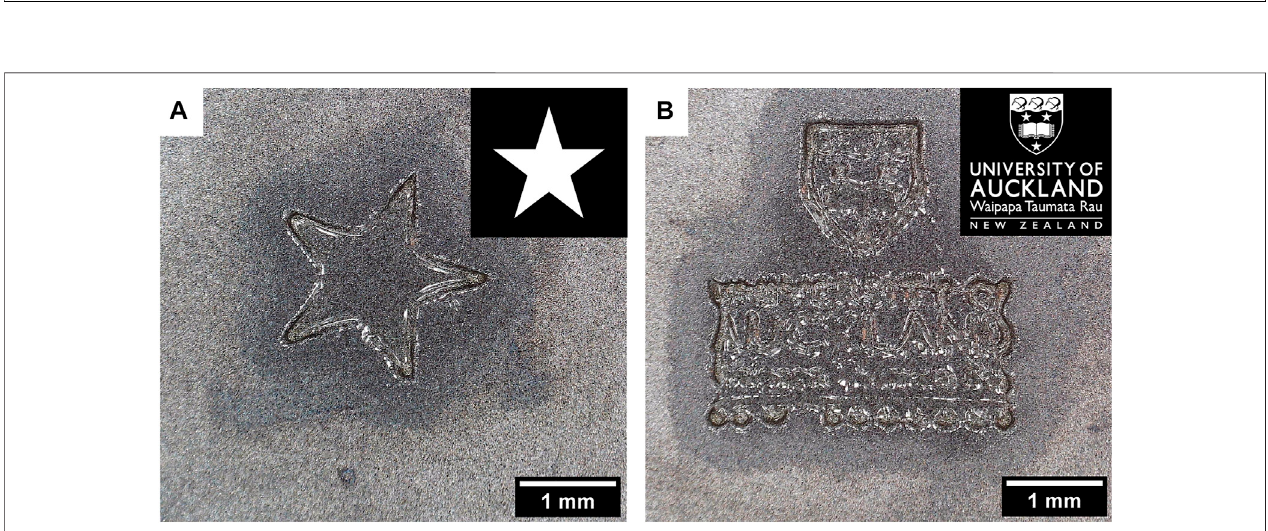
FIGURE8| Complexshapessuchasastar (A) ortheUniversityofAucklandlogo (B) wereprojectedfor4 minatthesurfaceofa10 wt%GelMApre-gel(scalebars: 1 mm). It resulted in hydrogels with speci fi c designs (the gels were dried for 1 h at RT before the pictures were taken).